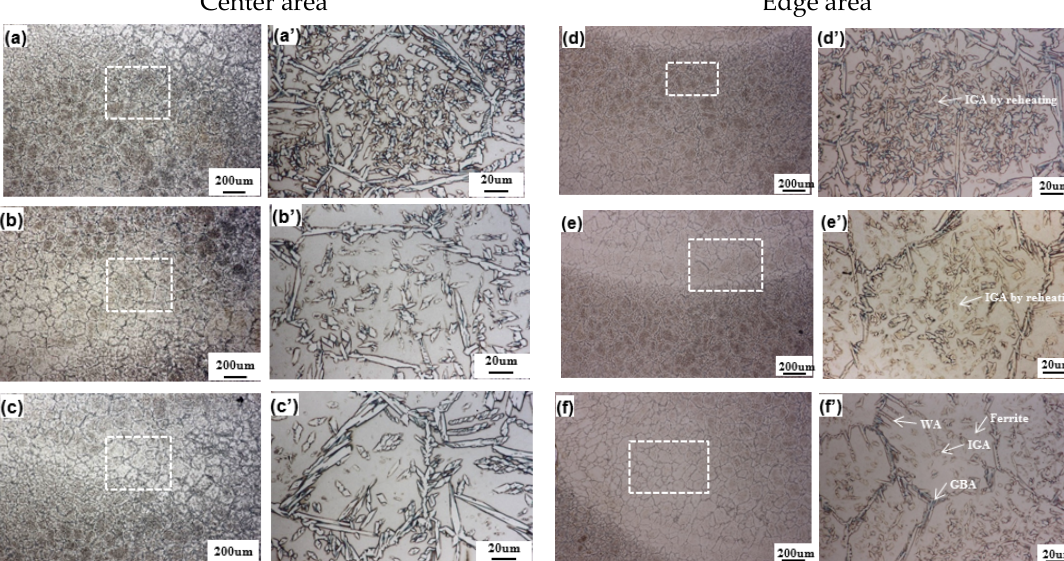
Figure 6. Microstructural analysis at the edge and the center of weld metal of medium heat input; the